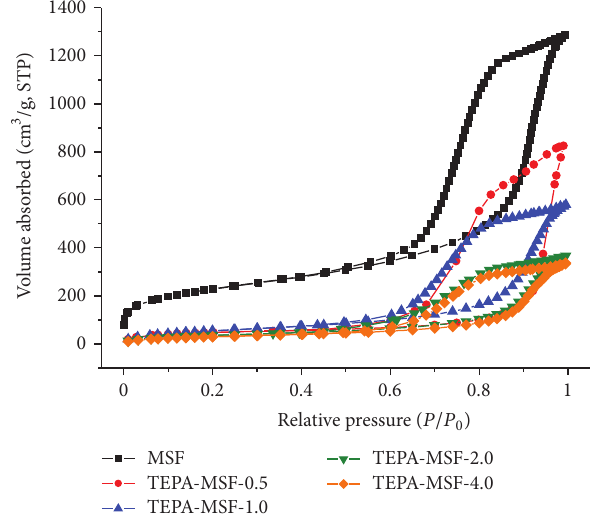
F 3: N adsorption-desorption isotherms of pure MSF and various TEPA-MSF- x 2